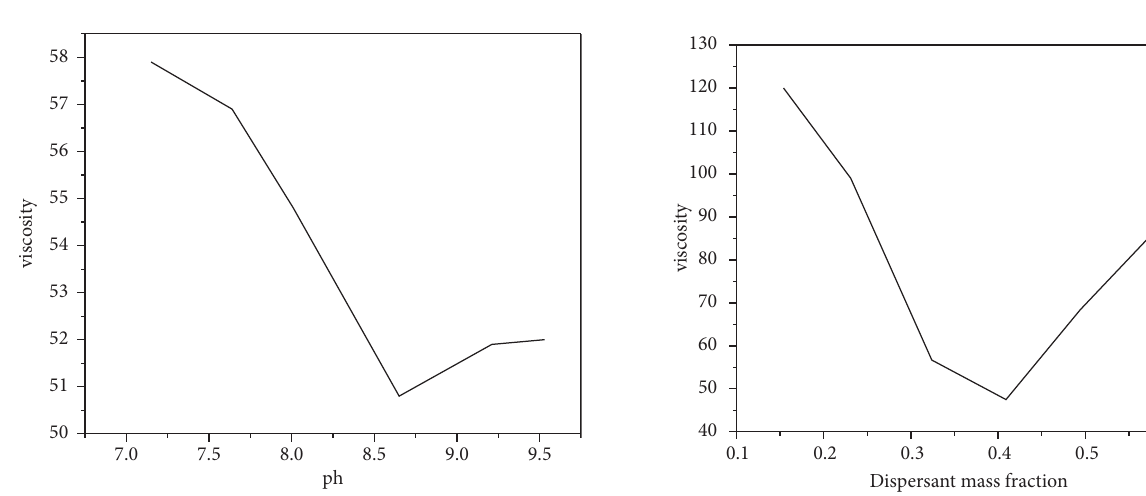
Figure 3: Relationship between viscosity and pH value.